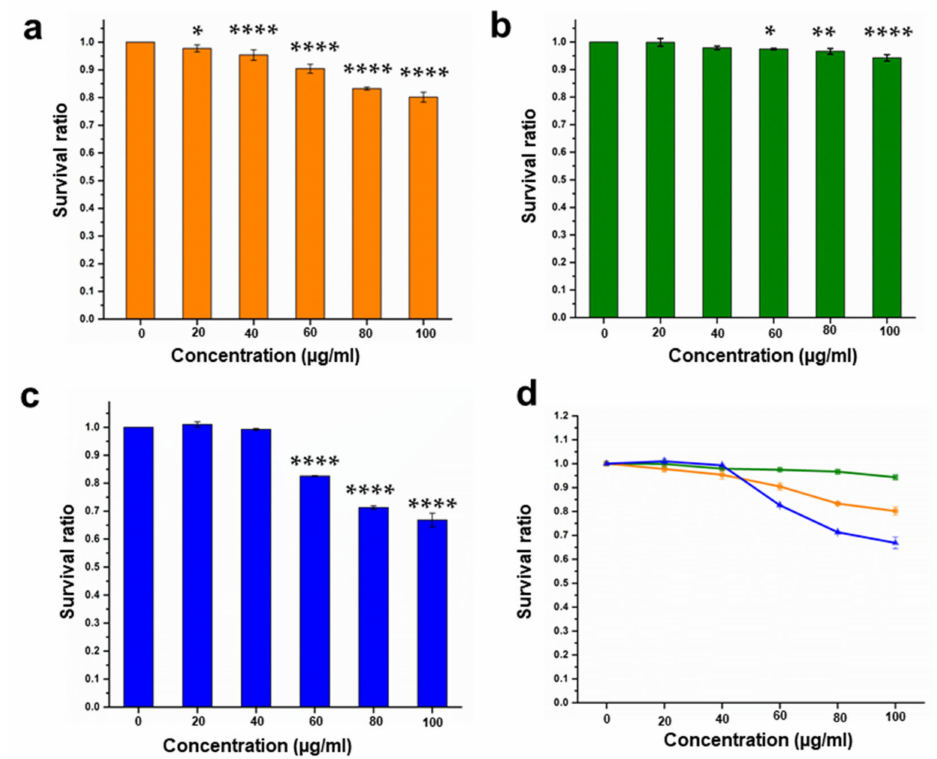
Figure 3. Cytotoxicity of AgInSe/ZnS QDs against ( a ) FM3A-Luc, ( b ) C26, ( c ) KM-Luc GFP, and ( d ) summary at different concentrations. Statistical significance was assessed by one-way ANOVA with